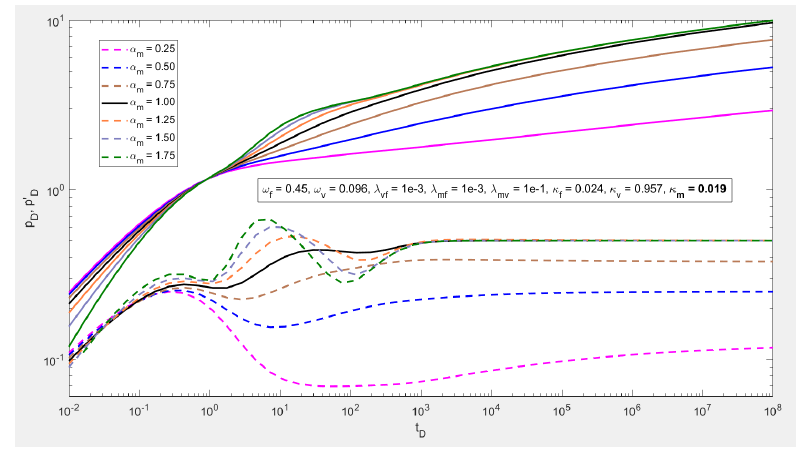
Figure 9. Effects of considering anomalous flow only in matrix rock, α f = 1, α v =